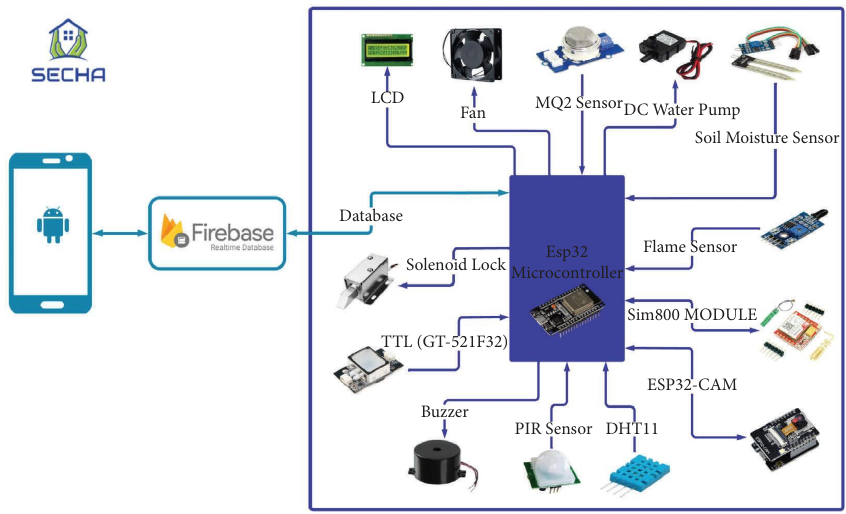
Figure 1: SECHA’s